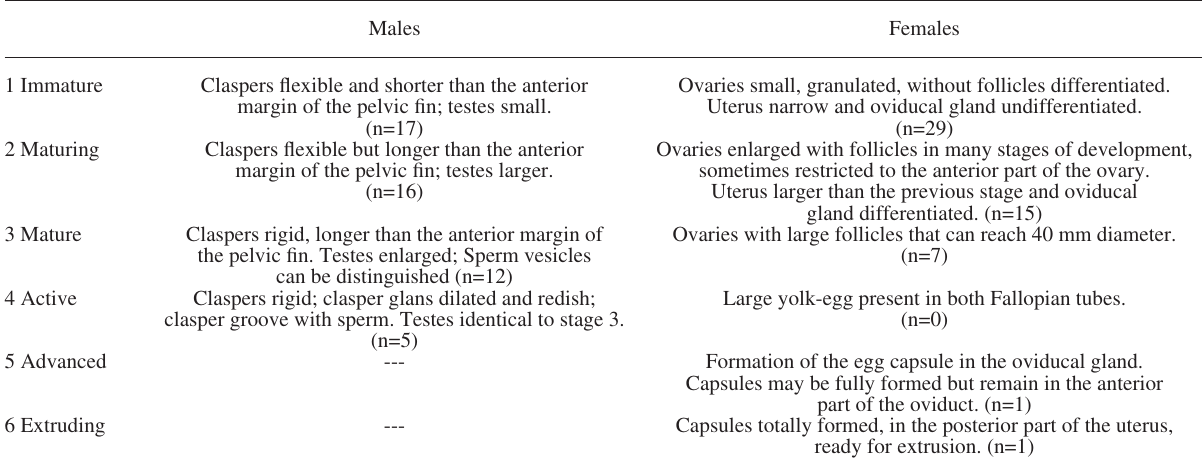
Table 1. – scale adopted for male and female maturity stage assignments, based on stehmann (2002) with indication of the number of sam- pled